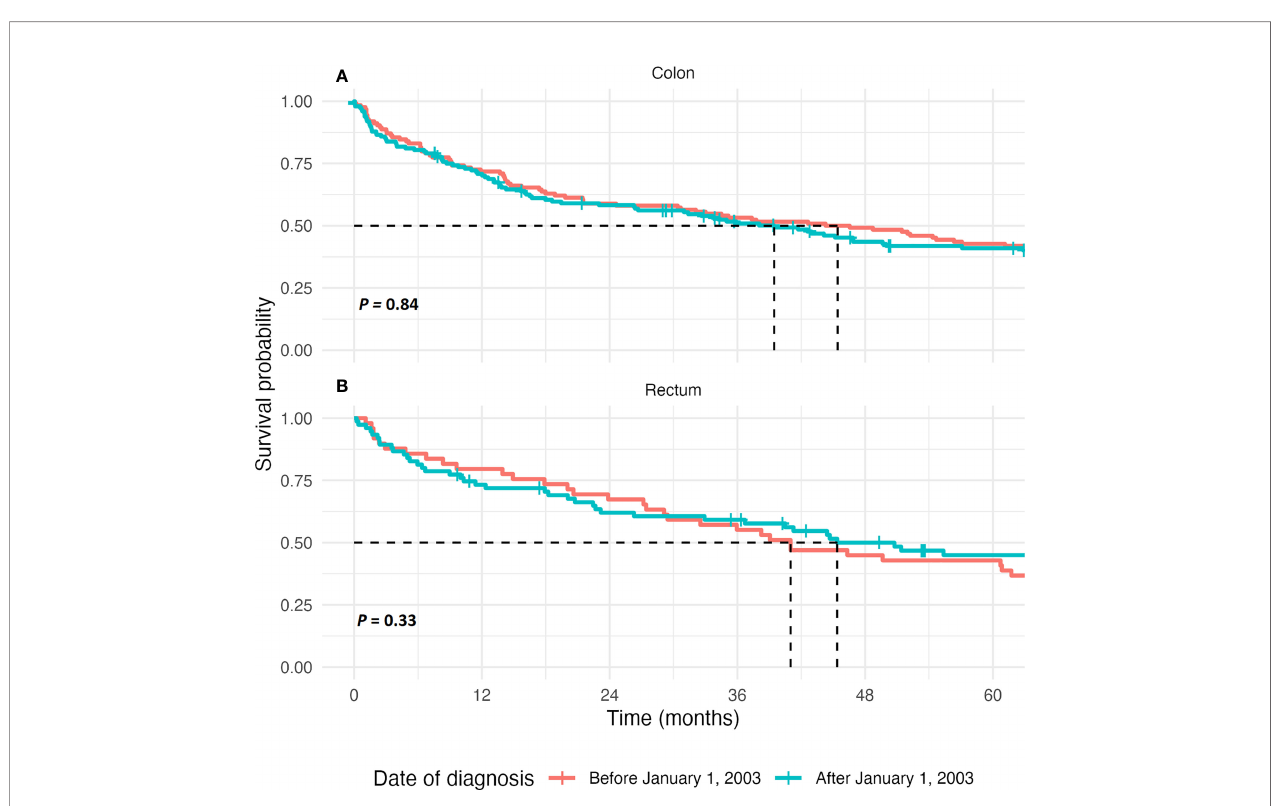
FIGURE 1 | Kaplan-Meier estimate of survival in colon cancer patients and rectal cancer patients. (A) The 5-year overall survival, in months, after diagnosis for patients of all tumor stages combined in colon cancer patients. The curves are compared using the Log-Rank test. (B) The 5-year overall survival, displayed in months, after diagnosis for patients of all tumor stages combined in rectal cancer patients. The curves are compared using the Log-Rank